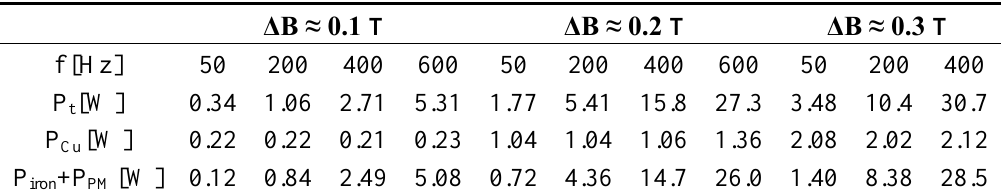
Table 2. Loss separation from the